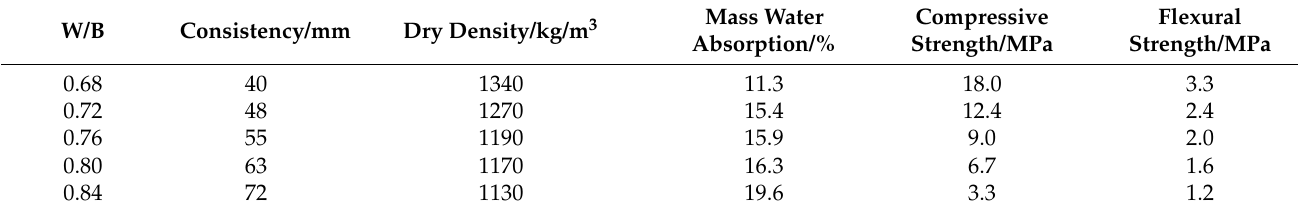
Table 4. Influence of water-binder ratio on the properties of